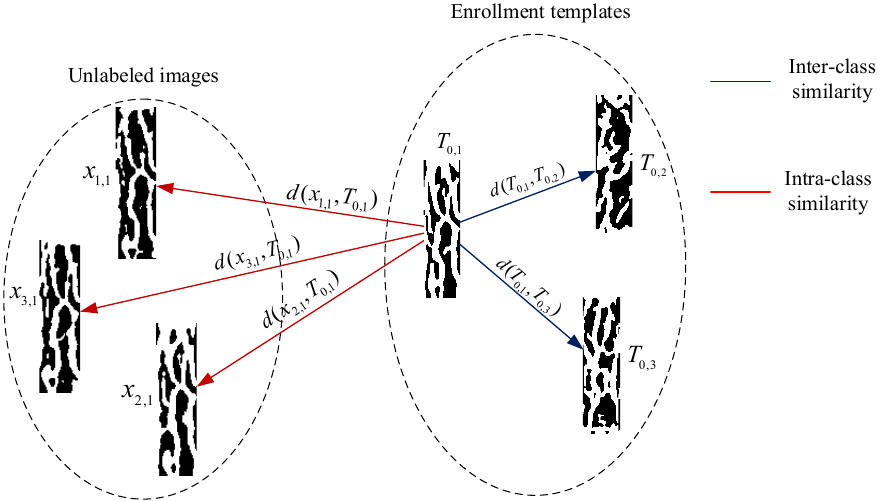
Figure 3. The intra-class similarity and inter-class similarity computation for enrollment template T 0,1 . There are three enrollment templates and three unlabeled samples for the first class. The red arrow implies that the similarity is computed by matching enrollment template T 0,1 and its three unlabeled images. The blue arrow implies that the similarity is computed by matching enrollment template T 0,1 and the remaining enrollment